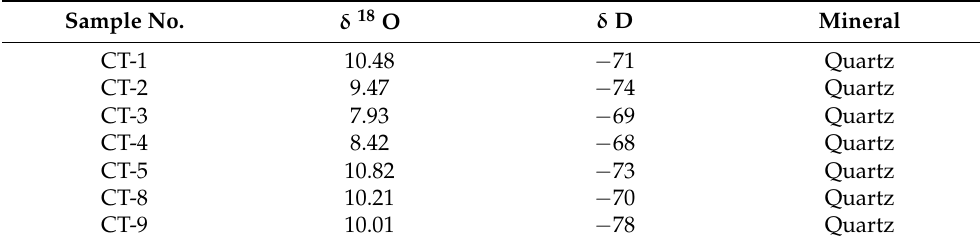
Table 2. δ 18 O- δ D isotope data of samples from gossan zone of Cerattepe VMSD. Sample